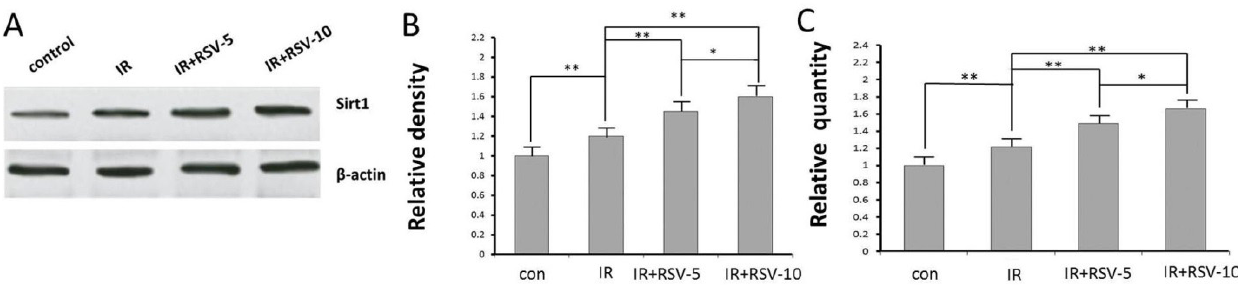
Figure 3. Effects of RSV on the expression levels of Sirt1. ( A ) Western blot analysis representative pattern from six rats, ( B ) protein expression levels and ( C ) mRNA expression levels of Sirt1 are expressed as relative density data which are the mean ± standard deviation from six rats in two independent experiments. The expression of Sirt1 protein was significantly enhanced in hippocampal tissue prepared from rats of IR group compared with rats of control group ( A and B ). Treatment with RSV reversed the irradiation-induced change in IR + RSV group compared with IR group ( A and B ). Sirt1 mRNA was significantly upregulated in IR group, compared with the control group.